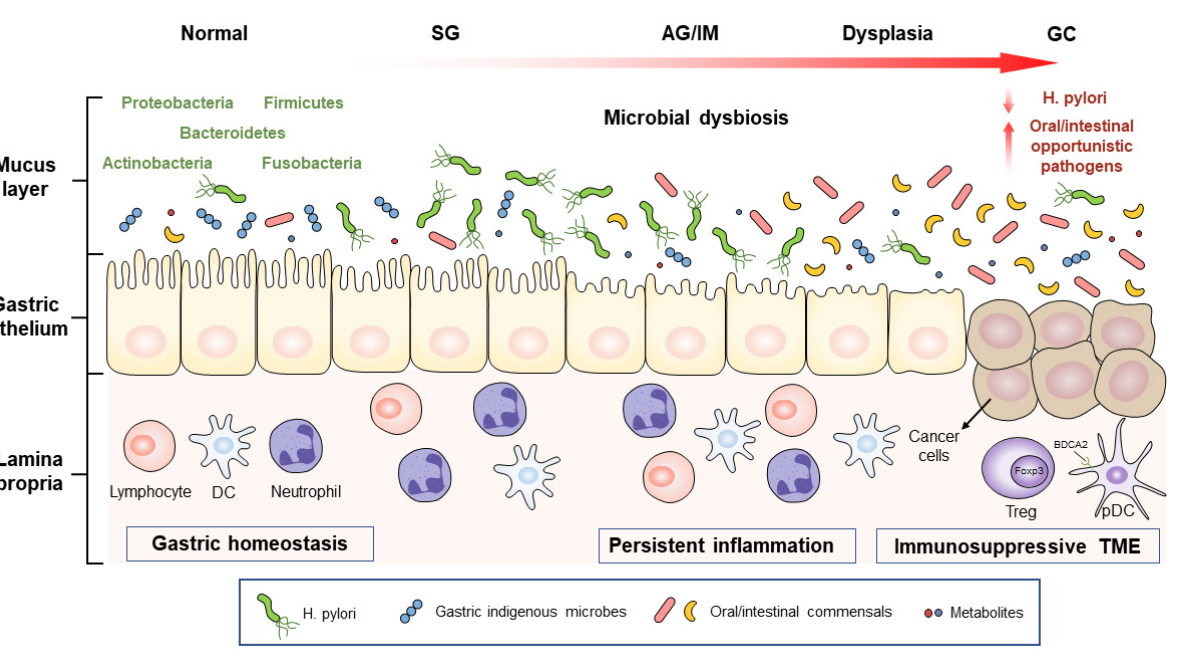
Figure 1. Schematic representation of the gastric microbial alteration across different stages of gastric carcinogenesis . H. pylori can trigger the initiation of GC, while non- H. pylori microorganisms, especially oral or intestinal opportunistic pathogens, are also involved in GC development. These microbes and their metabolites promote gastric carcinogenesis by inducing persistent inflammatory responses and immunosuppressive microenvironments. SG, superficial gastritis; AG, atrophic gastritis; IM, intestinal metaplasia; GC, gastric cancer; DC, dendritic cell; Treg, regulatory T cell; pDC, plasmacytoid dendritic cell; Foxp3, forkhead box P3; BDCA2, blood DC antigen 2; TME, tumor-associated microenvironment.